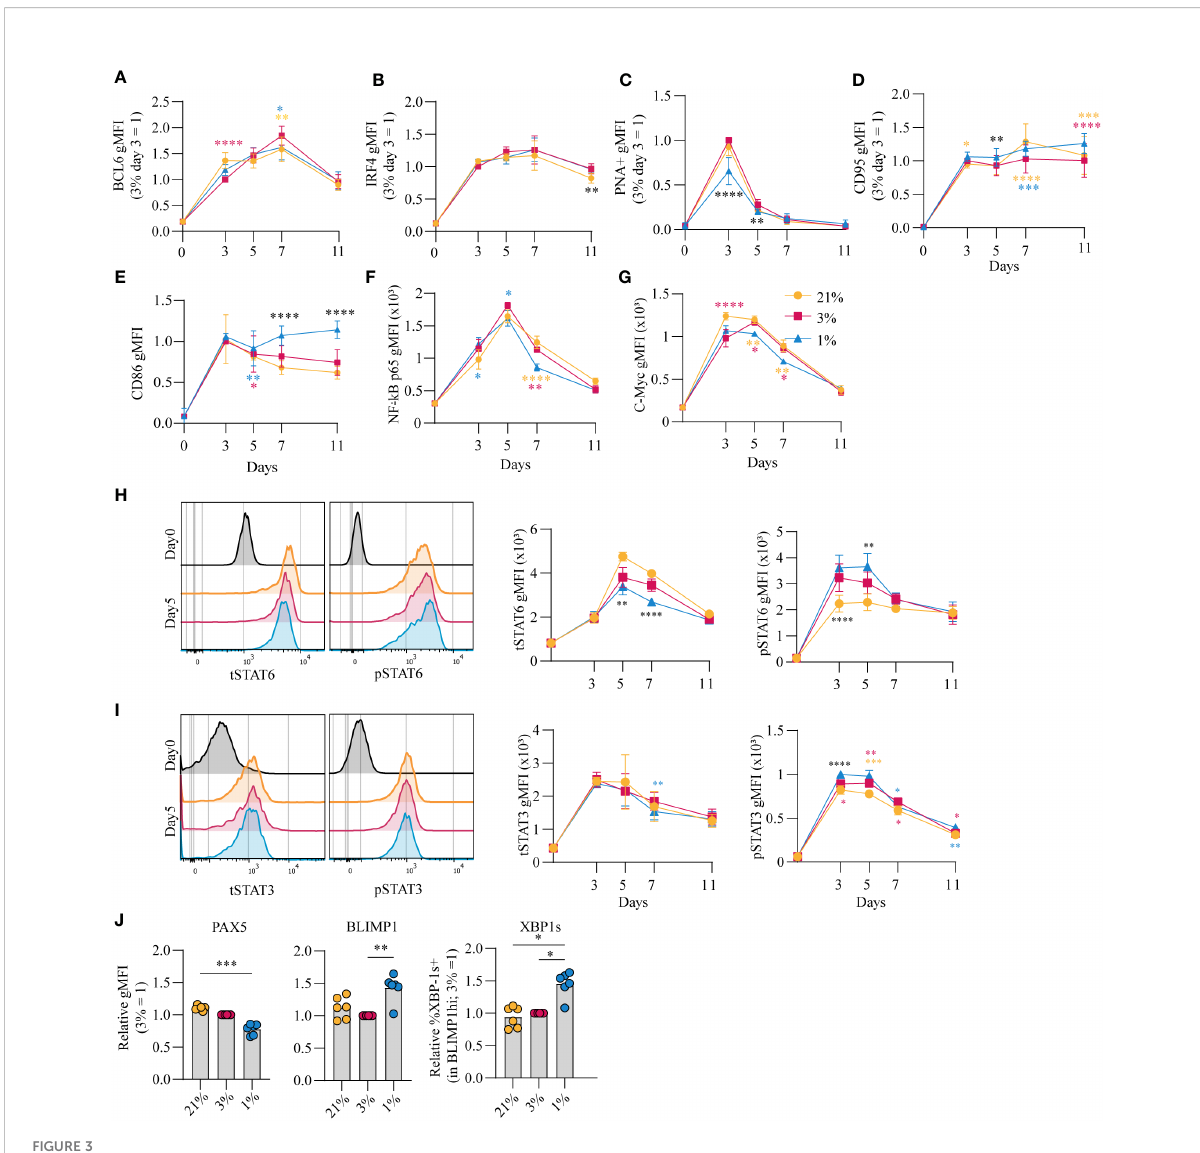
FIGURE 3 pO 2 steers canonical signaling pathways that direct naive B cell differentiation pathways (A-D) gMFI of (A) BCL-6 ( n = 6) (B) IRF4 ( n = 6) (C) PNA+ ( n = 6) (D) CD95 ( n = 6) (E) CD86 ( n = 6) (F) NF k B active subunit p65 ( n = 9) (G) c-Myc ( n = 9) (H-I) gMFI of (H) tSTAT6 and pSTAT6 and (I) tSTAT3 and pSTAT3 over time in culture ( n = 6) and (left panels) representative histogram overlays of pSTAT and tSTAT expression on day 5 of culture (J) gMFI of PAX5, BLIMP1 and %XBP-1s+ in BLIMP1hi cells (n=6) on day 7 (A-J) Bars represent means of biological replicates each composed of two technical replicates of 2 (H-J) or (A-G) 3 independent experiments (A-I) Differences in gMFI were determined using mixed-effects analysis using Tukey ’ s test for multiple comparisons. (J) Differences in gMFI were determined using repeated measures one-way ANOVA using Tukey ’ s tests for multiple comparisons. *p < 0.05, **p < 0.01, ***p < 0.001, ****p <